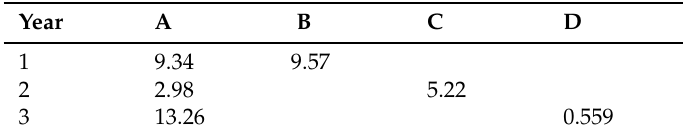
Table 4. Investment strategy I.